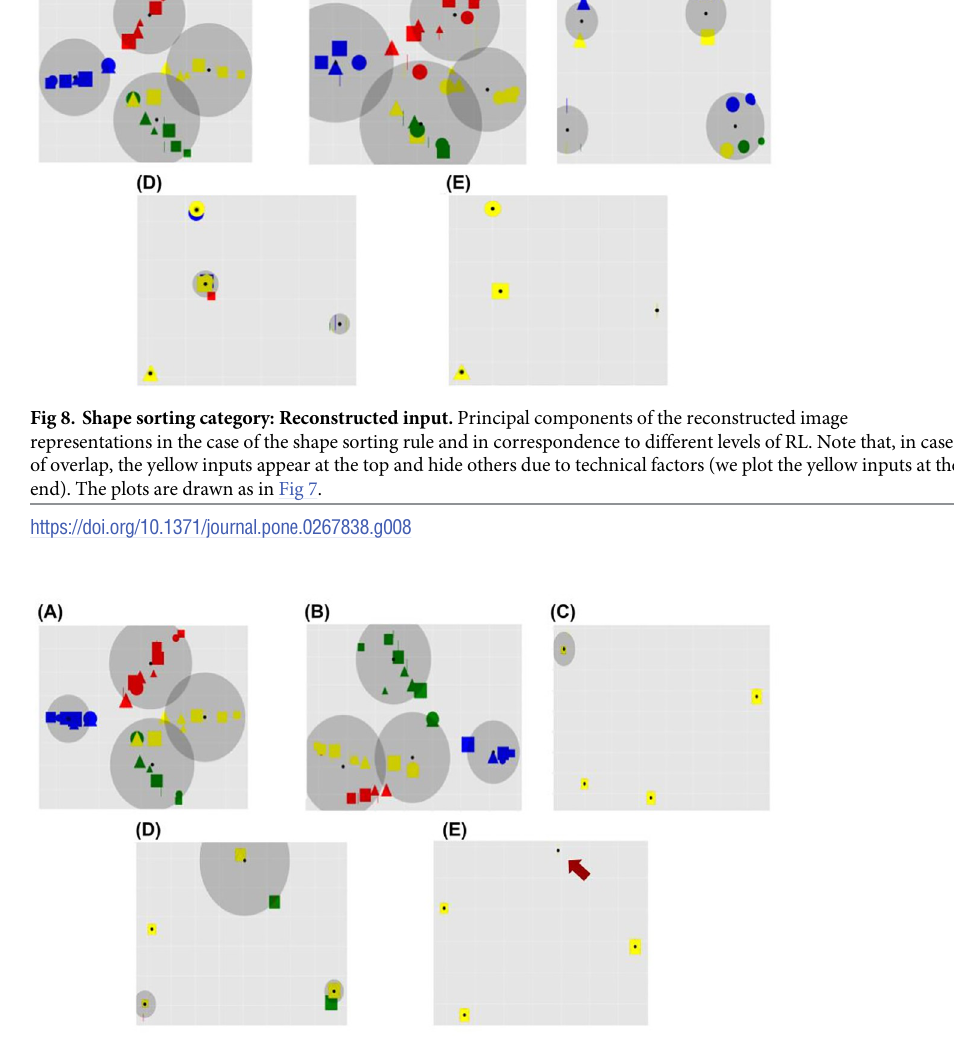
Fig 9. Size sorting category: Reconstructed input. Principal components of the reconstructed image representations in the case of the size sorting rule and in correspondence to different levels of RL. Note that, in case of overlap, the yellow inputs appear at the top and hide others due to technical factors (we plot the yellow inputs at the end). The graphs are drawn as in Fig 7. The red arrow in graph E indicates the centroid of a cluster that contains only the small bars but not the other small shapes.